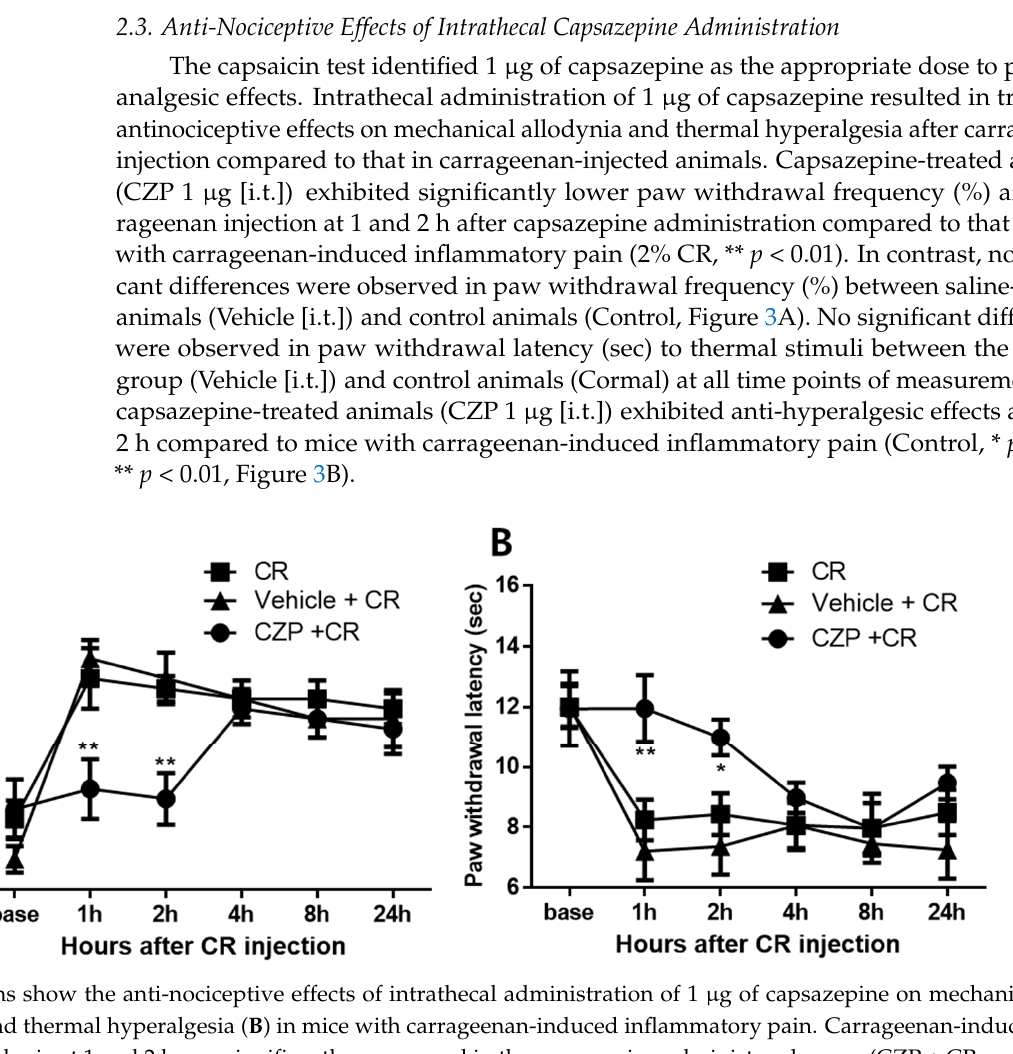
Figure 4. Graphs show the effect of intrathecal capsazepine treatment on the suppression of glutamate concentration in the spinal cord ( A ) and serum ( B ) of mice with carrageenan-induced inflammatory pain. Spinal glutamate concentration was significantly higher in carrageenan-injected animals (CR, n = 5) than in the control group (Control, n = 5, * p < 0.05). Glutamate concentration in the spinal cord was significantly lower in intrathecal capsazepine-treated animals (CZP + CR,